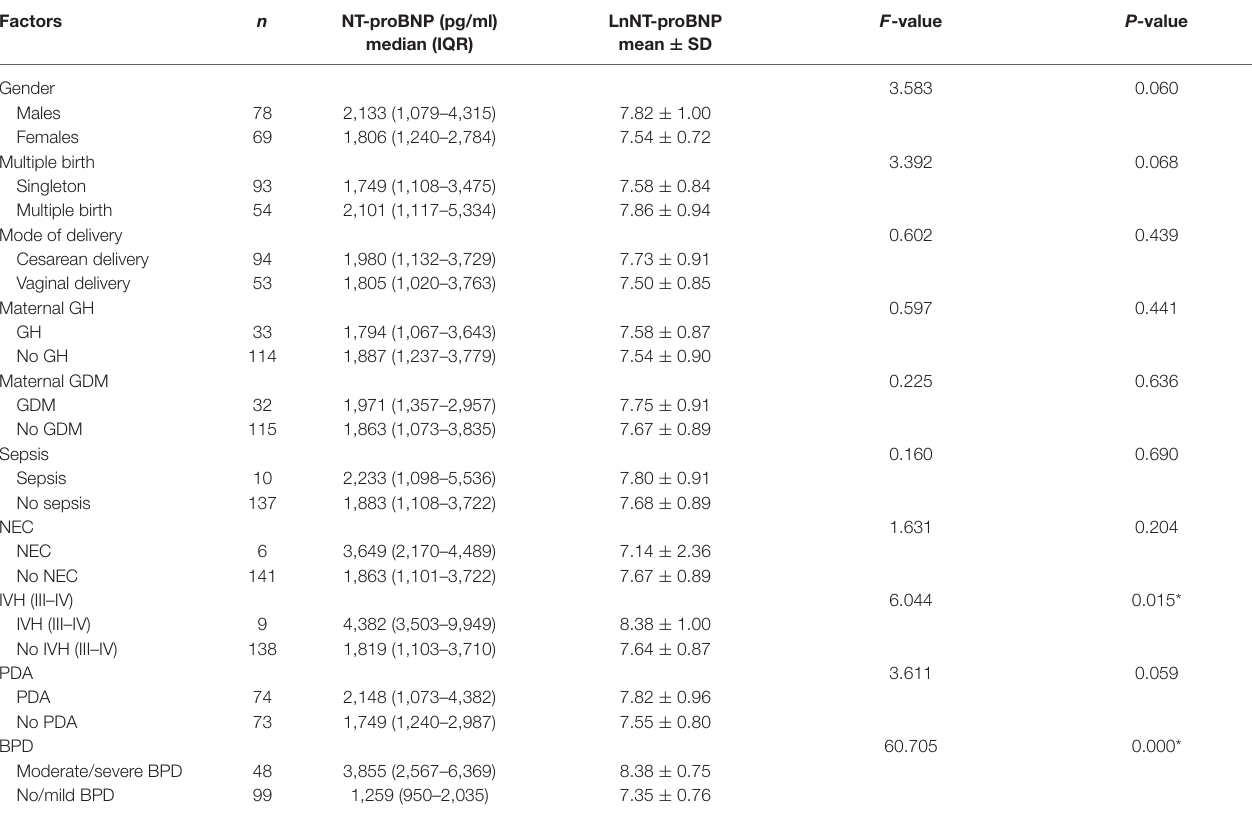
TABLE 2 | Effects of clinical characteristics on serum NT-proBNP.